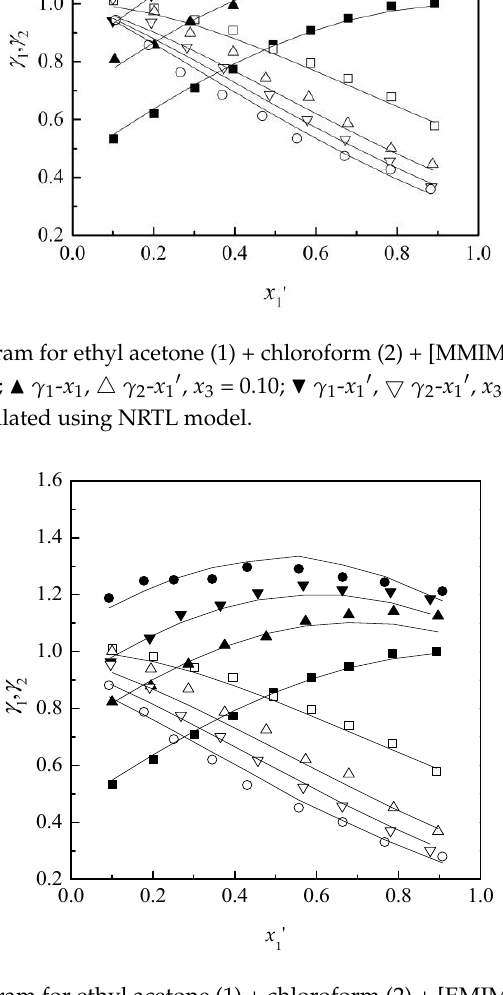
Figure 6. γ 1 ( γ 2 )- x 1 ′ diagram for ethyl acetone (1) + chloroform (2) + [EMIM][DEP]( 3) at 101.32 kPa: ■ γ 1 - x 1 ′ , □ γ 2 - x 1 ′ , x 3 = 0; ▲ γ 1 - x 1, △ γ 2 - x 1 ′ , x 3 = 0.10; ▼ γ 1 - x 1 ′ , ▽ γ 2 - x 1 ′ , x 3 = 0.15; ● γ 1 - x 1 ′ , ○ γ 2 - x 1 ′ , x 3 = 0.20; Solid line, calculated using NRTL model.